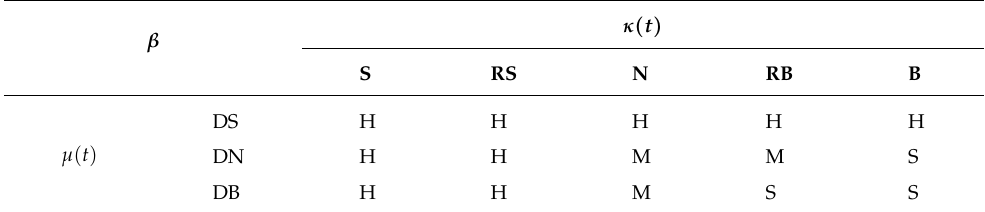
Table 1. Fuzzy rules for the weight coefficient β of the obstacle distance term.